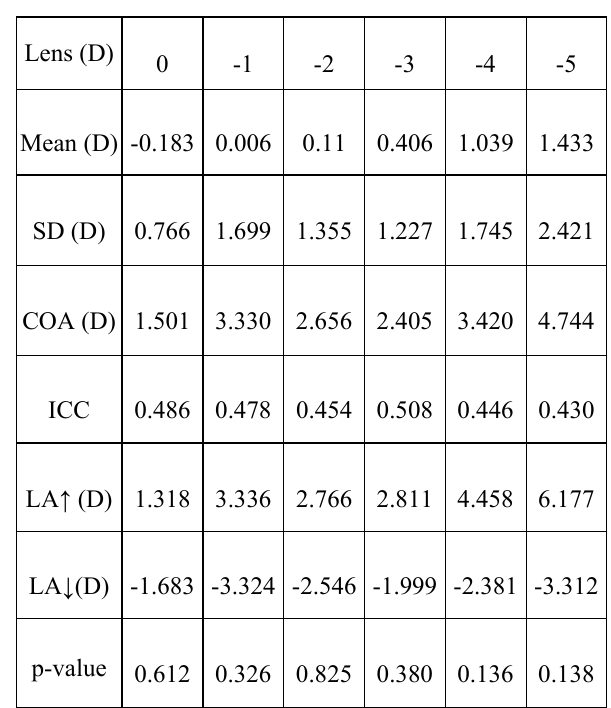
Table 1. Mean, standard deviation (SD), coefficient of agreement (COA), intra-class correlation coefficient of accommodative lag (ICC), limit of agreement (LA) differences obtained with AR and aberrometer, for different accommodative